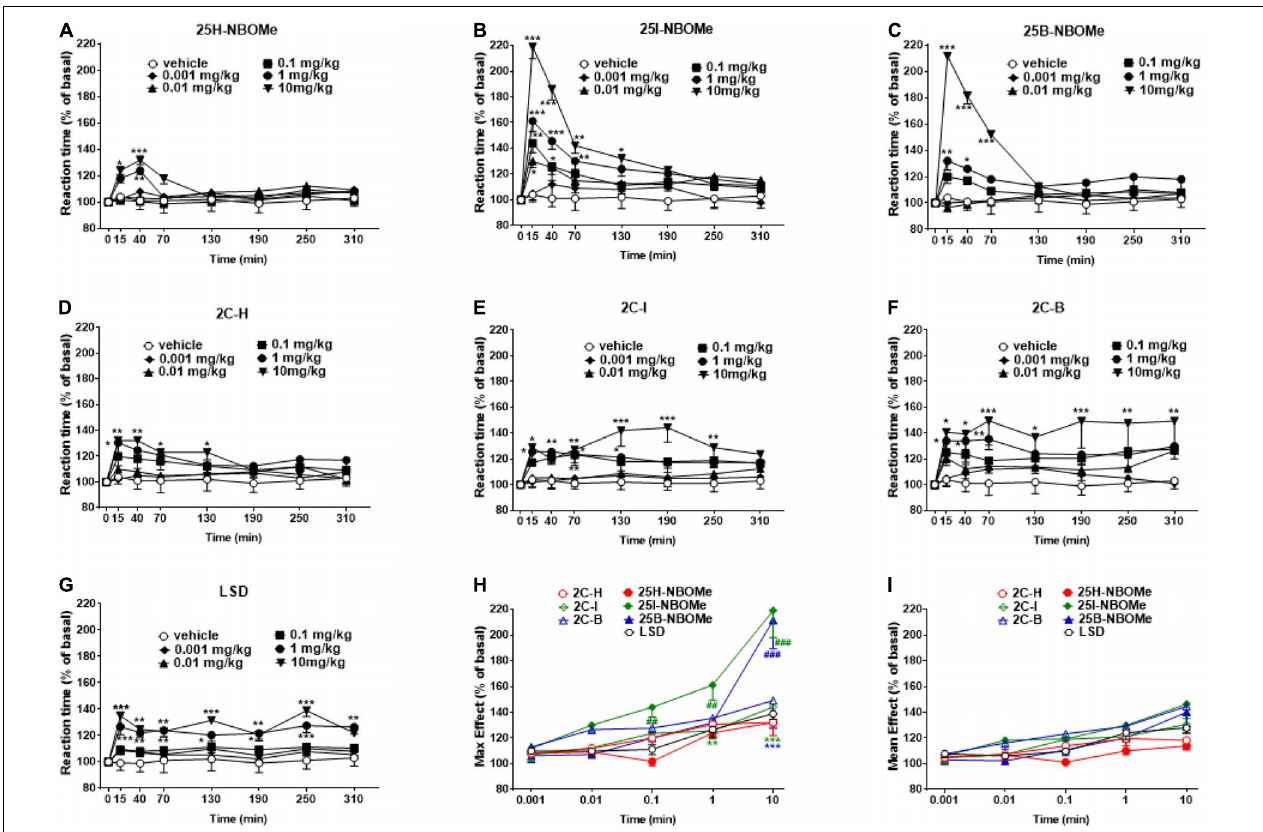
FIGURE 5 | Effect of 25H-NBOMe (0.001–10 mg/kg i.p.) (A) 25I-NBOMe (0.001–10 mg/kg i.p.) (B) 25B-NBOMe (0.001–10 mg/kg i.p.) (C) 2C-H (0.001–10 mg/kg i.p.) (D) 2C-I (0.001–10 mg/kg i.p.) (E) 2C-B (0.001–10 mg/kg i.p.) (F) , and LSD (0.001–10 mg/kg i.p.) (G) on reaction time test in the mice and comparison of the maximum (H) and average (I) effect observed in 5 h. Data are expressed as mean ± SEM ( n = 8/group). Statistical analysis was performed by two-way ANOVA followed by Bonferroni’s test (A–G) for multiple comparisons for the dose–response curve of each compound at different time points. The comparison of maximum effect observed in 5 h was also presented (H,I) . * p < 0.05, ** p < 0.01, *** p < 0.001 vs. vehicle; ## p < 0.01, ### p < 0.001 vs. LSD.